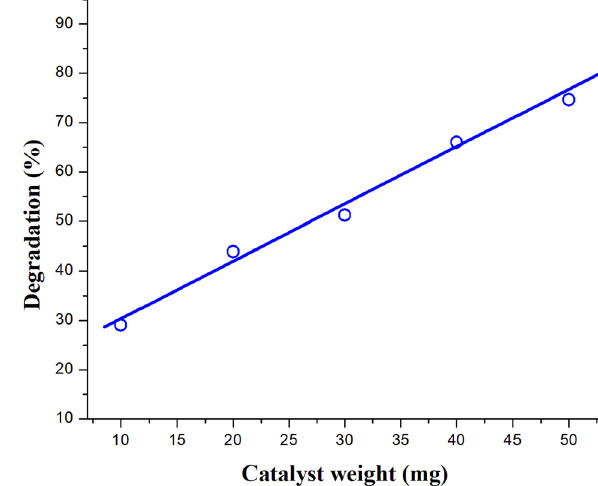
Figure 11: Kinetics of MO - dye photodegradation over Fe - ZnO - 5 under sunlight irradiation.